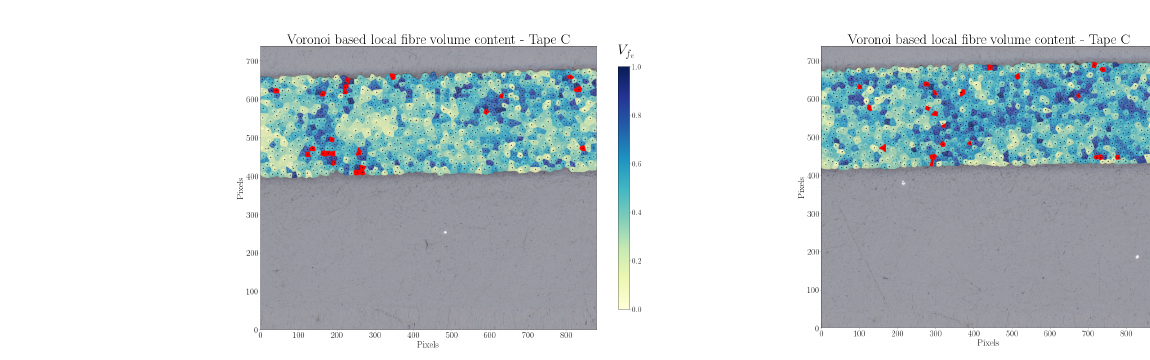
Figure 12. Two adjacent Voronoi analyses of tape C.